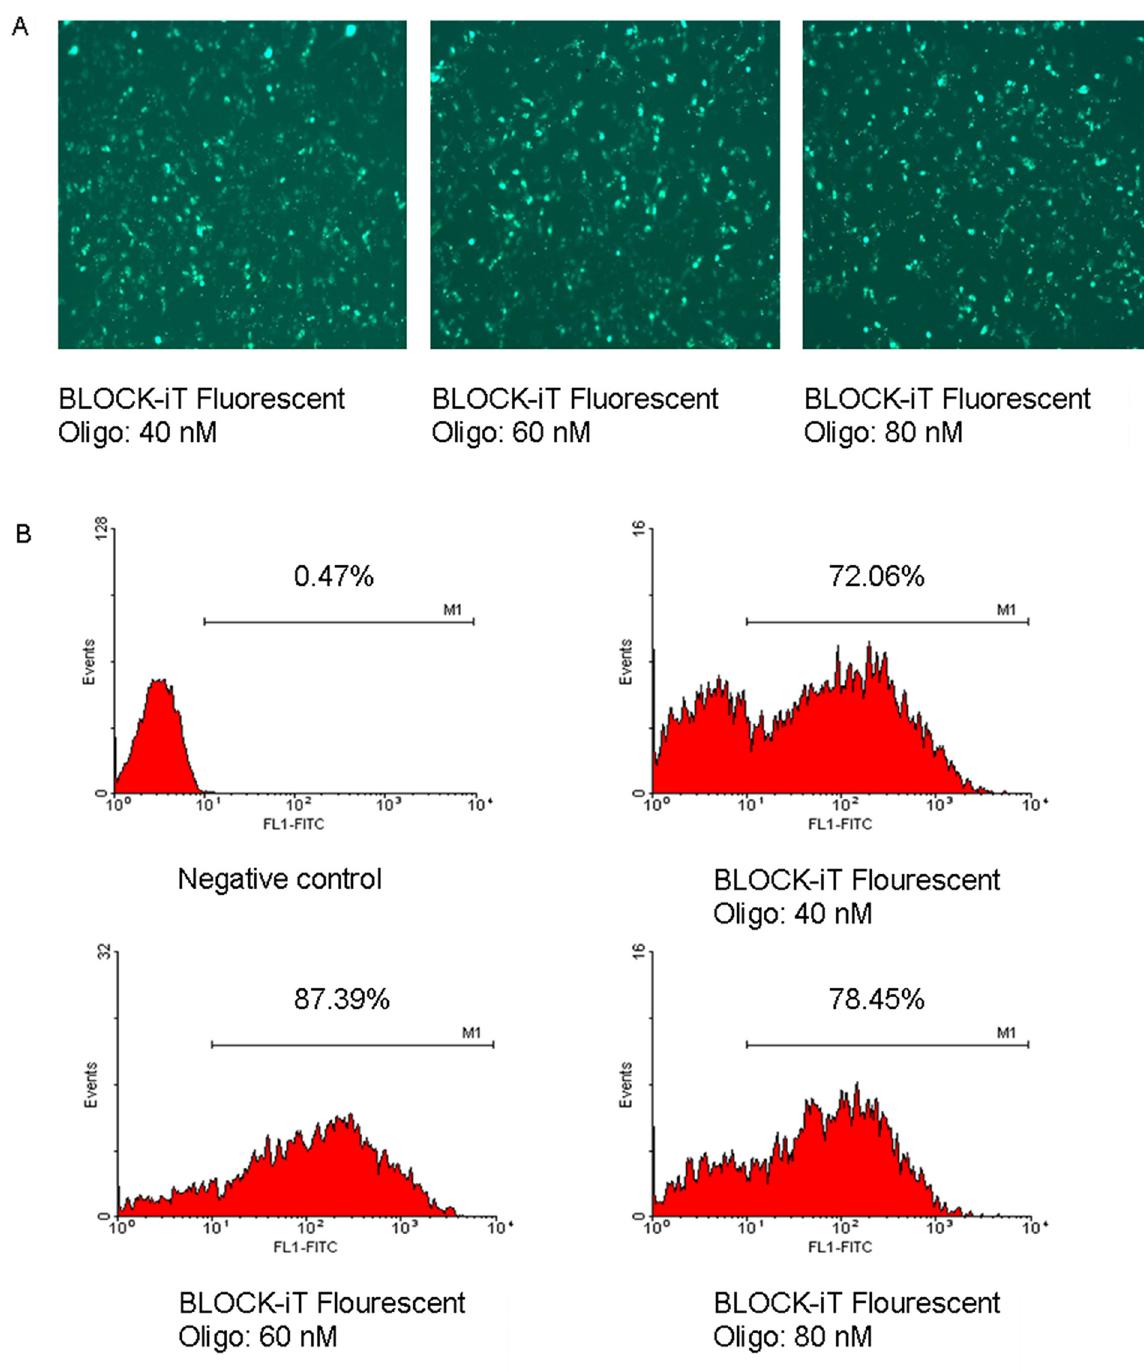
Fig 1. Transfection efficiency of siRNA in RD cells. (A) Cellular distribution of BLOCK-iT Fluorescent Oligo in transfected RD cells. RD cells were transfected with different concentrations of BLOCK-iT Fluorescent Oligo and 2 μ l of Lipofectamine 2000. At 24 h after transfection, the cells were observed under a fluorescence microscope. (B) RD cells transfected with BLOCK-iT Fluorescent Oligo were quantified with flow cytometry. The cells were assayed in three independent experiments.